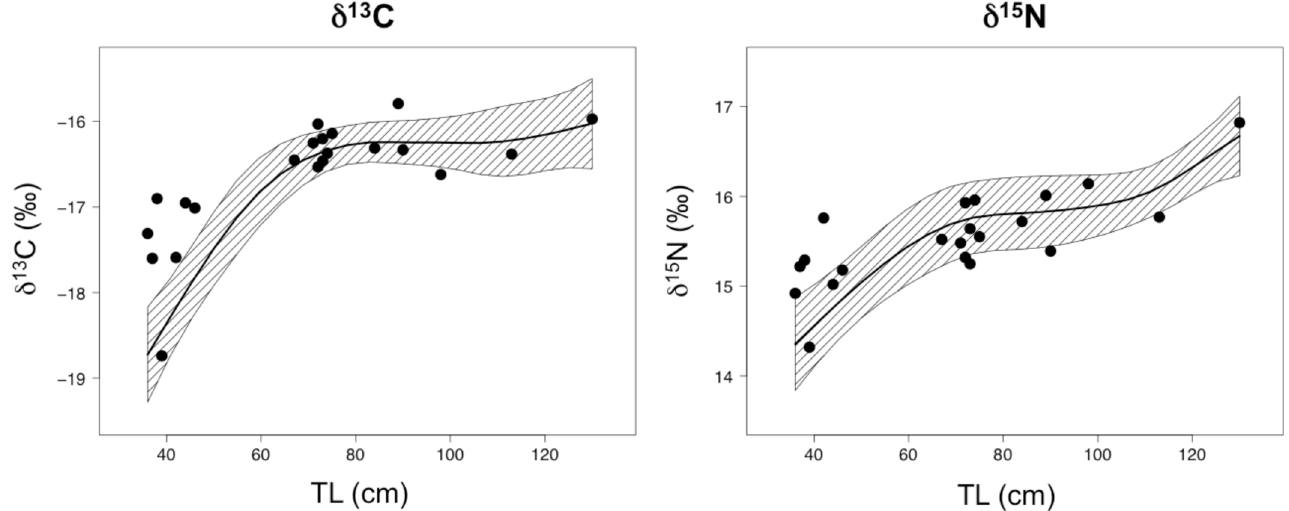
Fig. 4. Relationships between d 13 C values (left) or d 15 N values (right) ( ‰ ) and total length (TL, cm) in meagre collected in 2010 for SIA ( N =21) and presenting a wide range of individual sizes. Results from the GGAM models ( fi tted to individual d 13 C or d 15 N values to identify size-related trends) are plotted on raw isotope data (i.e. 70% ethanol preserved) and TL data in the form of a smoother (i.e. polygon including 95% con fi dence interval), illustrating the modelled relationships between parameters (see